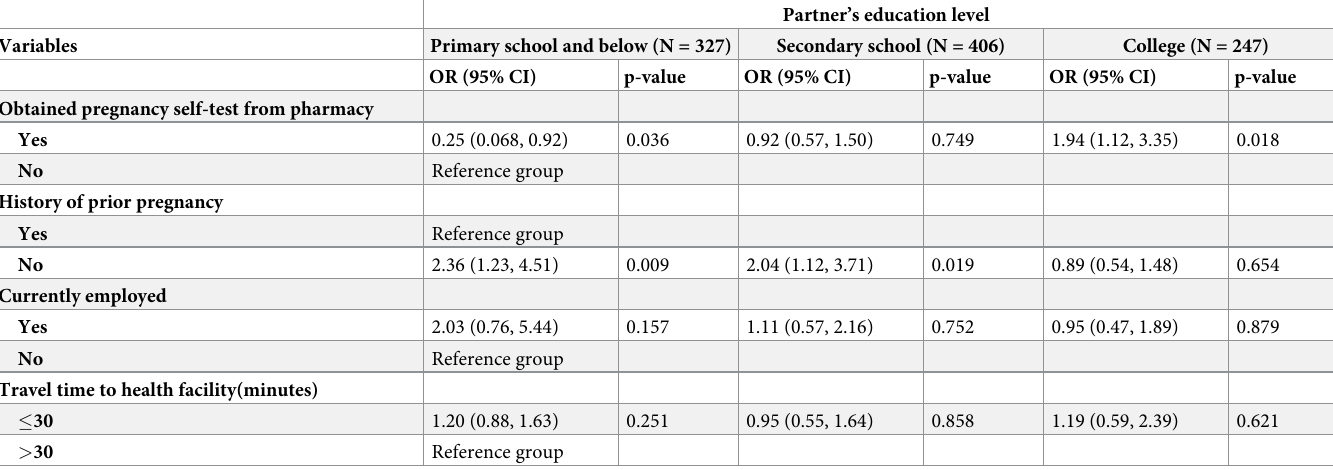
Table 4. Logistic regression examining the variables associated with early ANC initiation and stratified by partner’s education